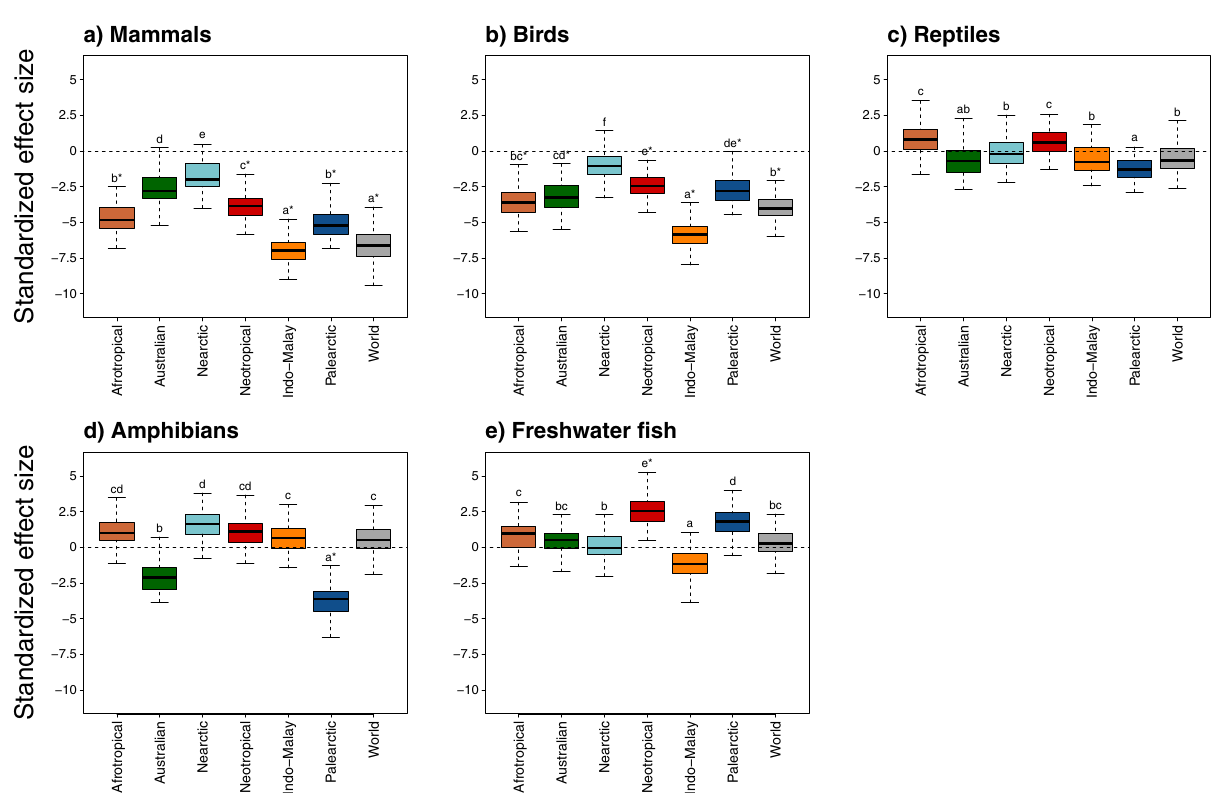
Fig. 4 Differences in functional diversity loss among realms for the -NT extinction scenario. For each taxonomic group (panels a – e ), we tested whether the standardized effect size (SES) values of the potential loss in the functional richness of each biogeographic realm signi fi cantly differ from each other using multiple pairwise comparison tests. SES distributions were obtained using a bootstrapping procedure ( n = 1000 repetitions, see the ‘ Methods ’ for details). The results correspond to the -NT extinction scenario where the species considered as threatened by IUCN (i.e. CR, EN, VU and NT) were removed. Similar analyses were made for all the extinction scenarios and presented in Supplementary Fig. 9. We show for each group a compact letter displays of all pairwise comparisons with a signi fi cance level of 5%. The SES values signi fi cantly different than expected under null models are identi fi ed by an asterisk. Boxes show the median, fi rst and third quartiles and boxes whiskers cover 95% of the distribution range. Source data are provided as a Source data fi